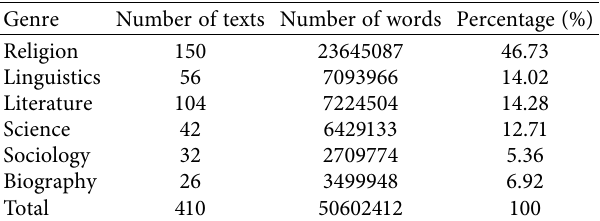
Table 4: Statistics of the KSUCCA corpus [23].